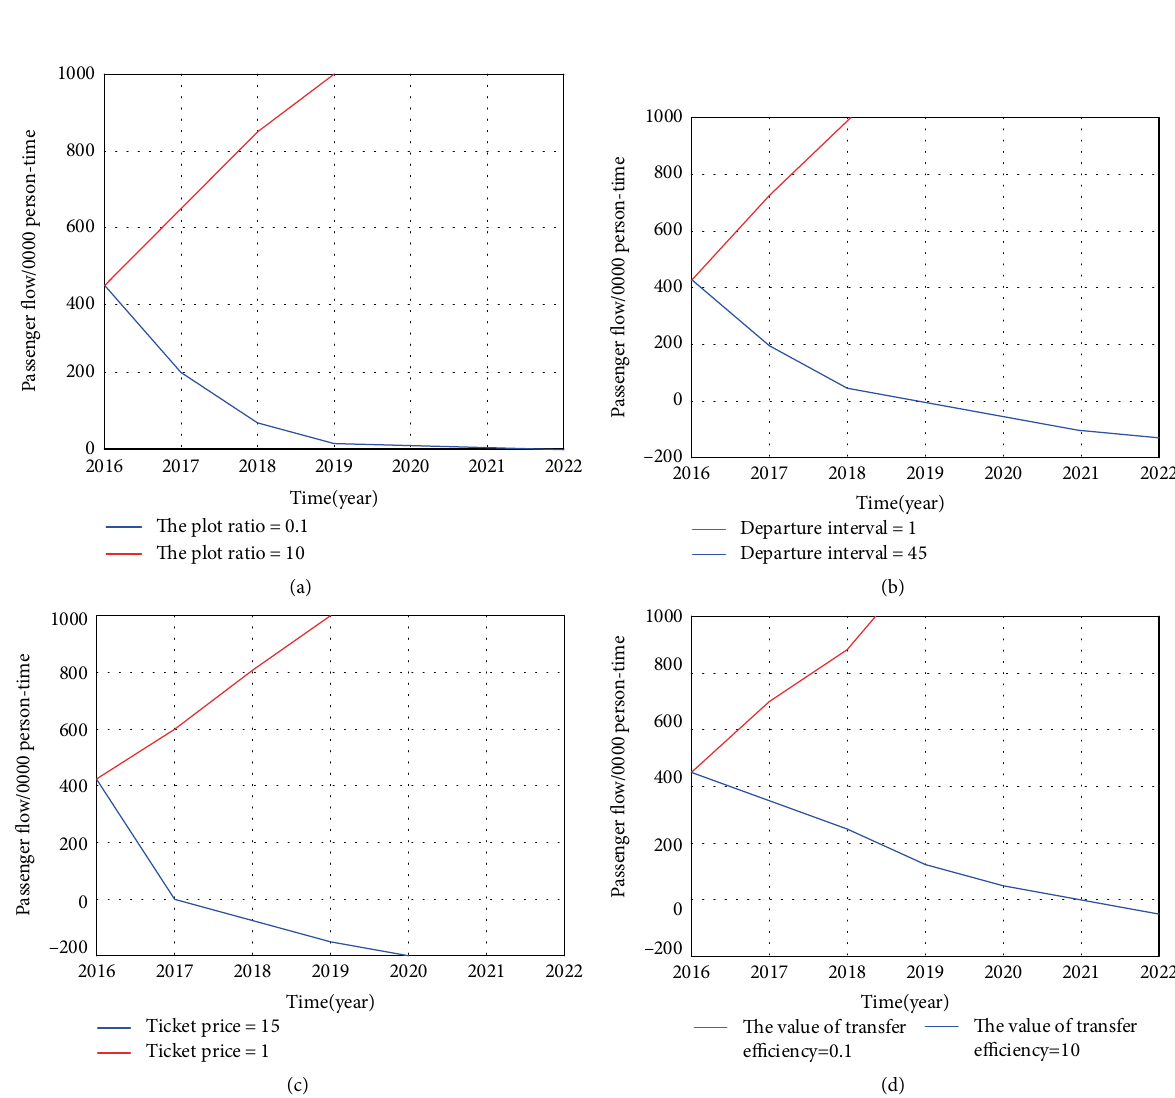
Figure 5: Extreme conditional tests for each variable. (a) Extreme condition test for plot ratio, (b) Extreme condition test for departure interval, (c) Extreme condition test for ticket price, and (d) Extreme condition test for transfer